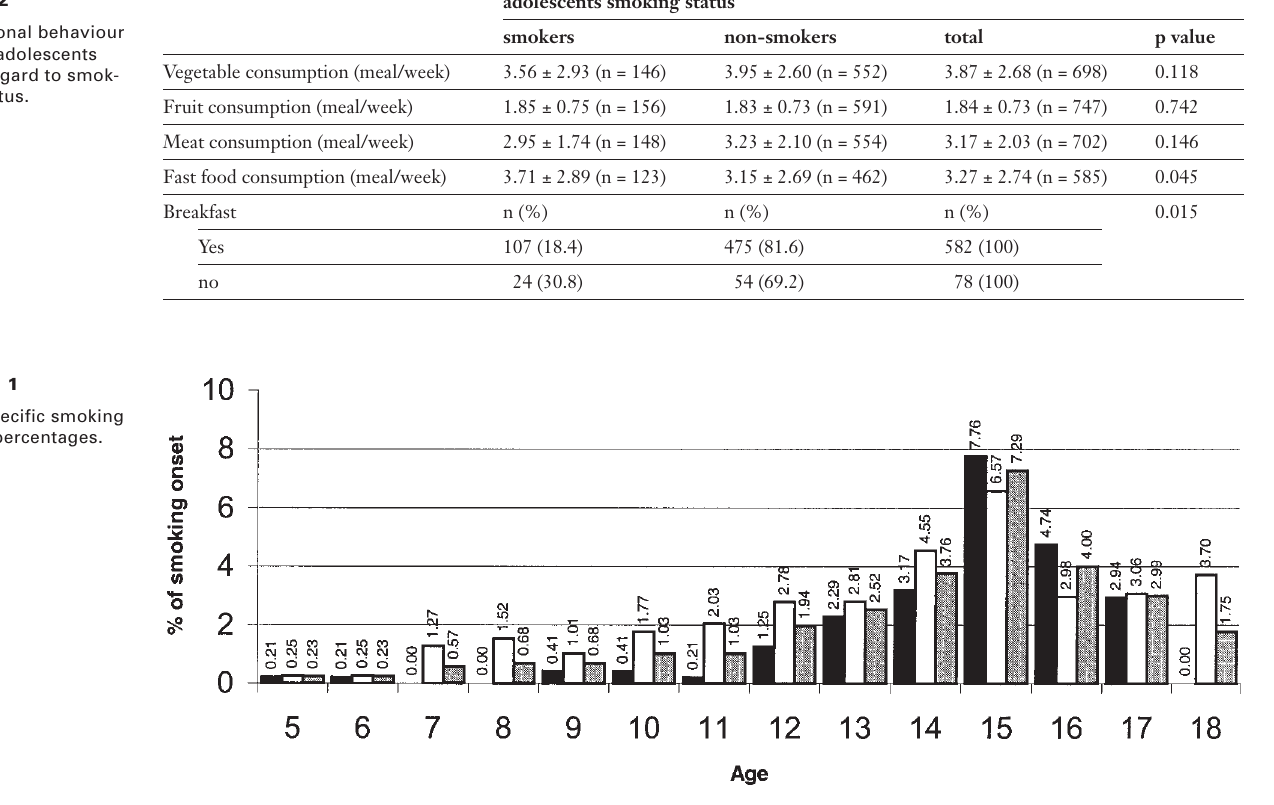
Nutritional behaviour of the adolescents with regard to smok- ing